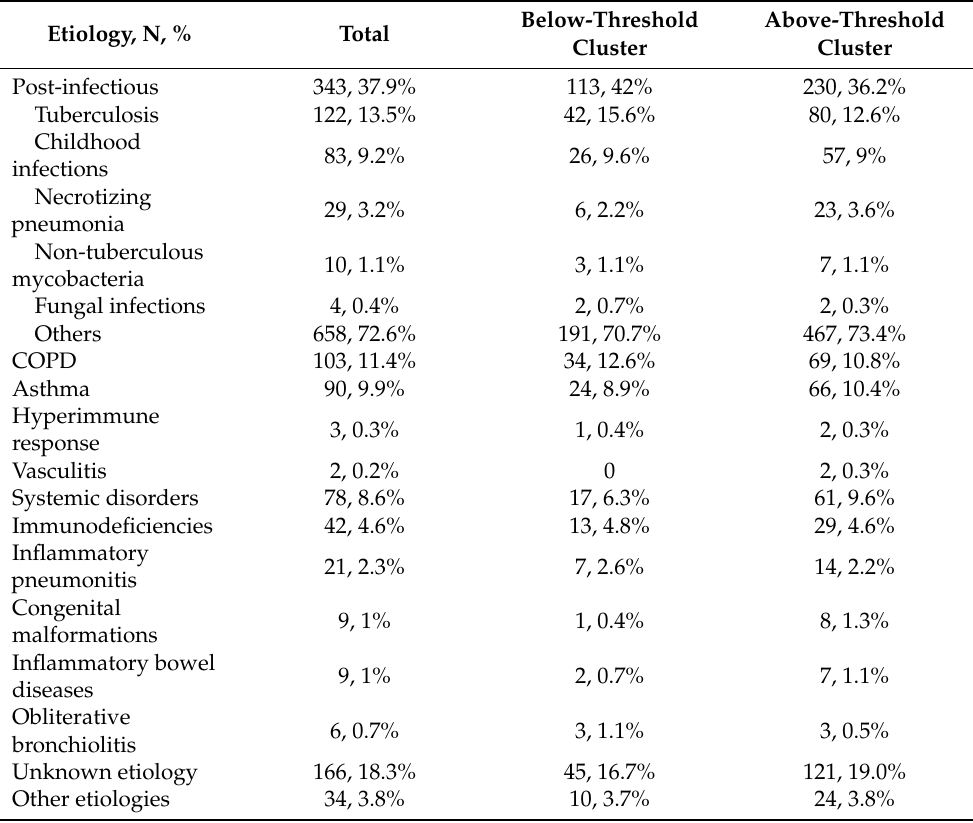
Table 3. Etiology of the non-CF bronchiectasis patients.